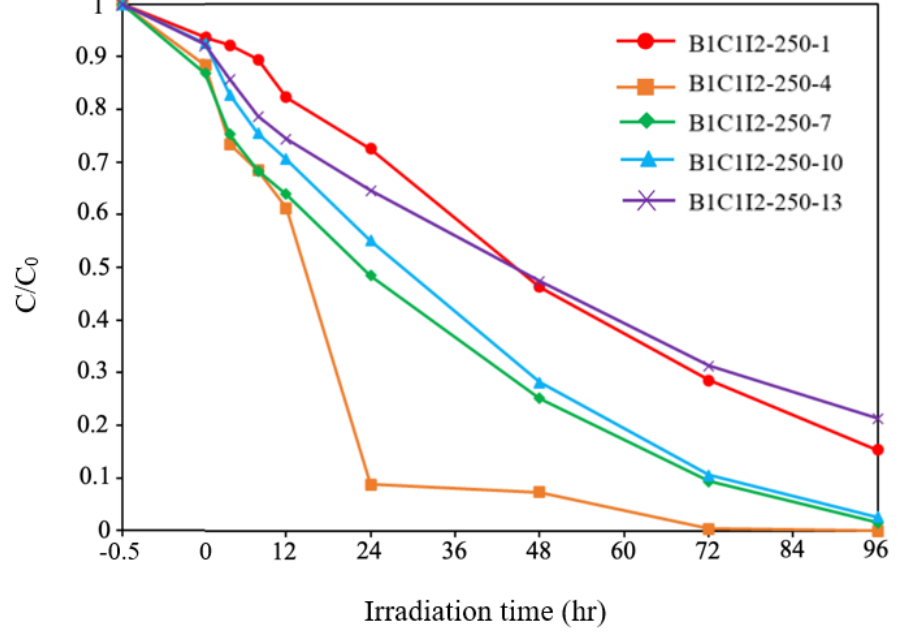
Figure 9 presents the CV degradation efficiency diagram of BiO m Cl n /BiO p I q for a Cl:I ratio of 1:2, a hydrothermal temperature of 250 ◦ C, and different pH values. The degraded pollutant in this study was 100 mL of 10 ppm of CV dye. By using relevant first-order kinetic equations (( dC t / dt ) = kC t and ln ( C 0 / C t ) = kt , where C t is concentration of the CV dye at time t and k is the reaction rate constant), we determined the k and R 2 values for different pH values. Specifically, for the pH values of 1, 4, 7, 10, and 13, the k values were 0.017,